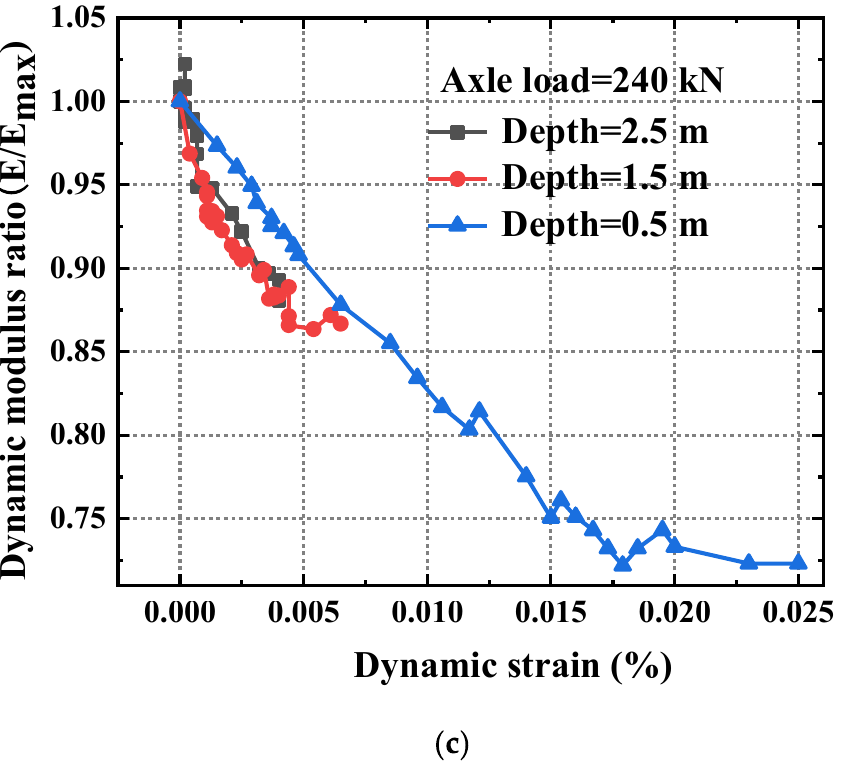
Figure 17. Modulus-reduction curves at different depths. ( a ) Axle load = 50 kN; ( b ) Axle load = 130 kN; ( c ) Axle load = 240 kN.